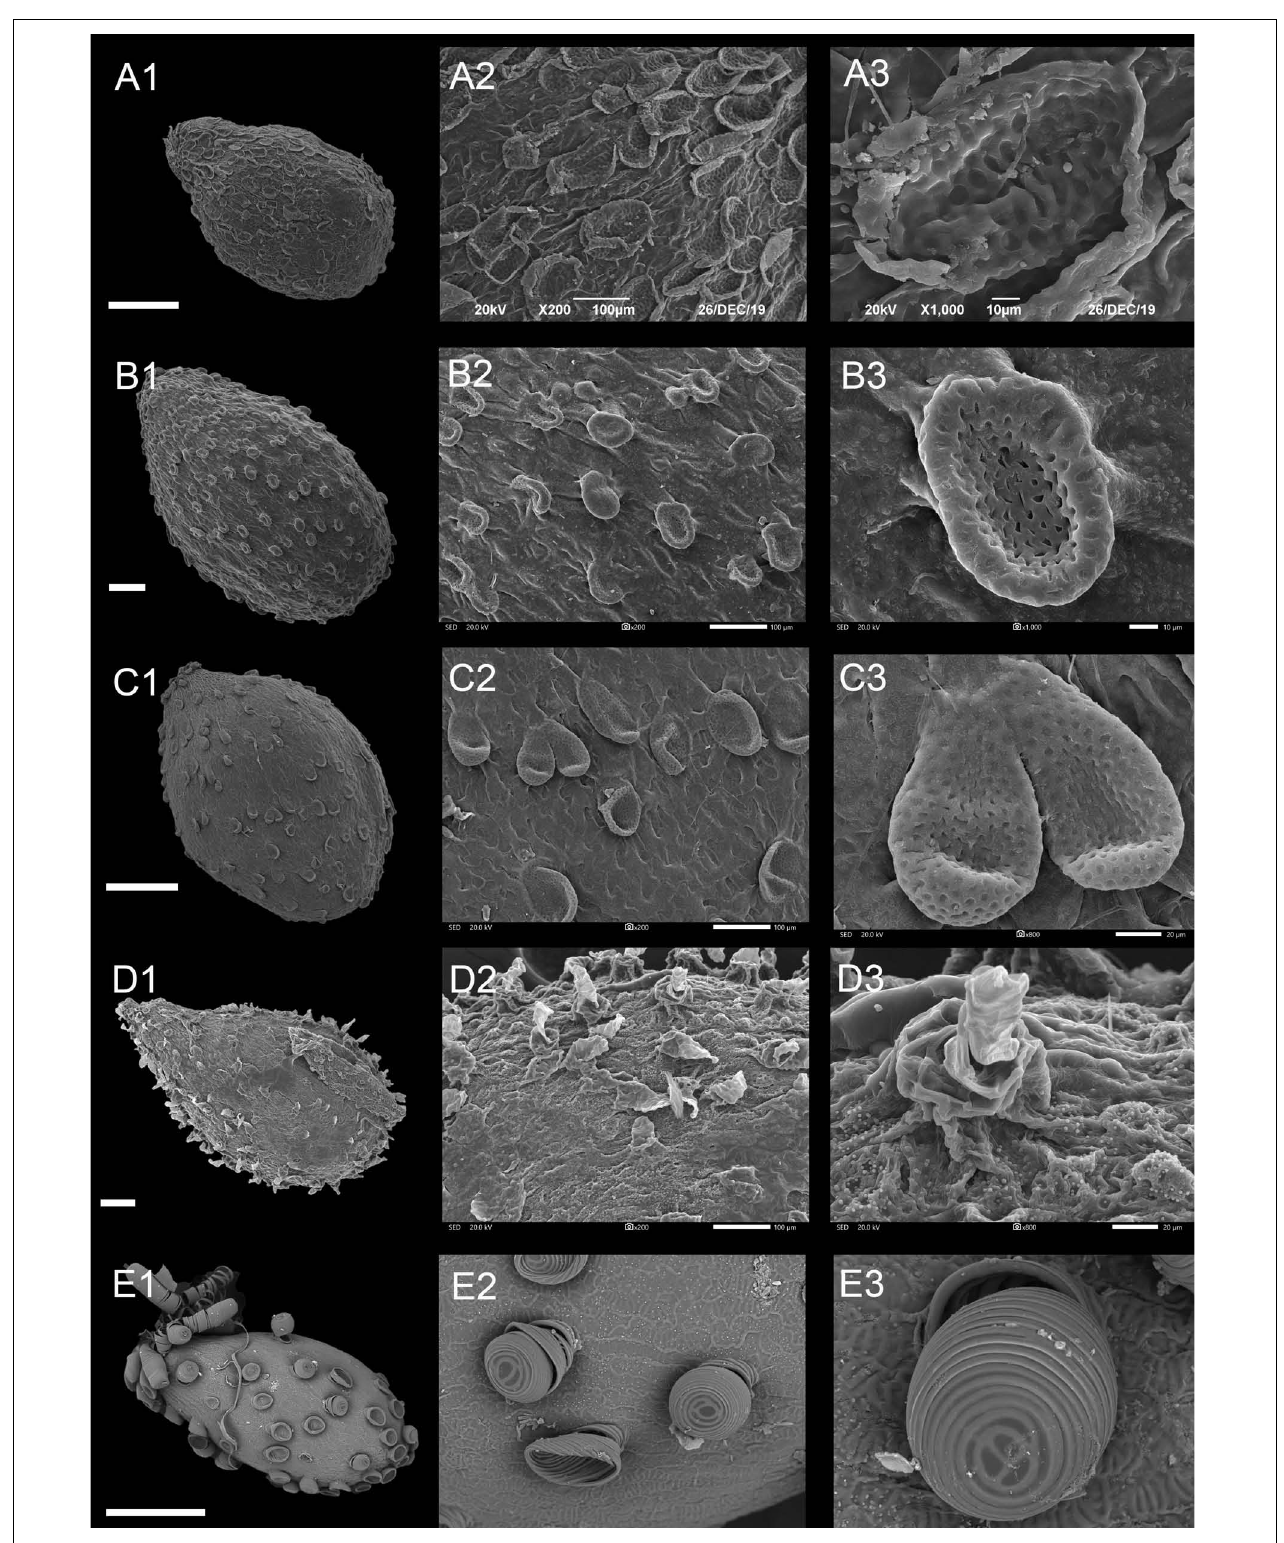
FIGURE 5 | Scanning electron microscope images of seeds from appendicular type of Impatiens . (A1–E1) Whole view; (A2–E2,C3–E3) Partial view. (A1–A3) Impatiens monticola , (B1–B3) Impatiens jinpingensis , (C1–C3) Impatiens latipetala , (D1–D3) Impatiens psedoviola , (E1–E3) Impatiens xanthina . Scale bars: (A1,C1,E1) = 500 µ m, (B1,D1) = 200 µ m.